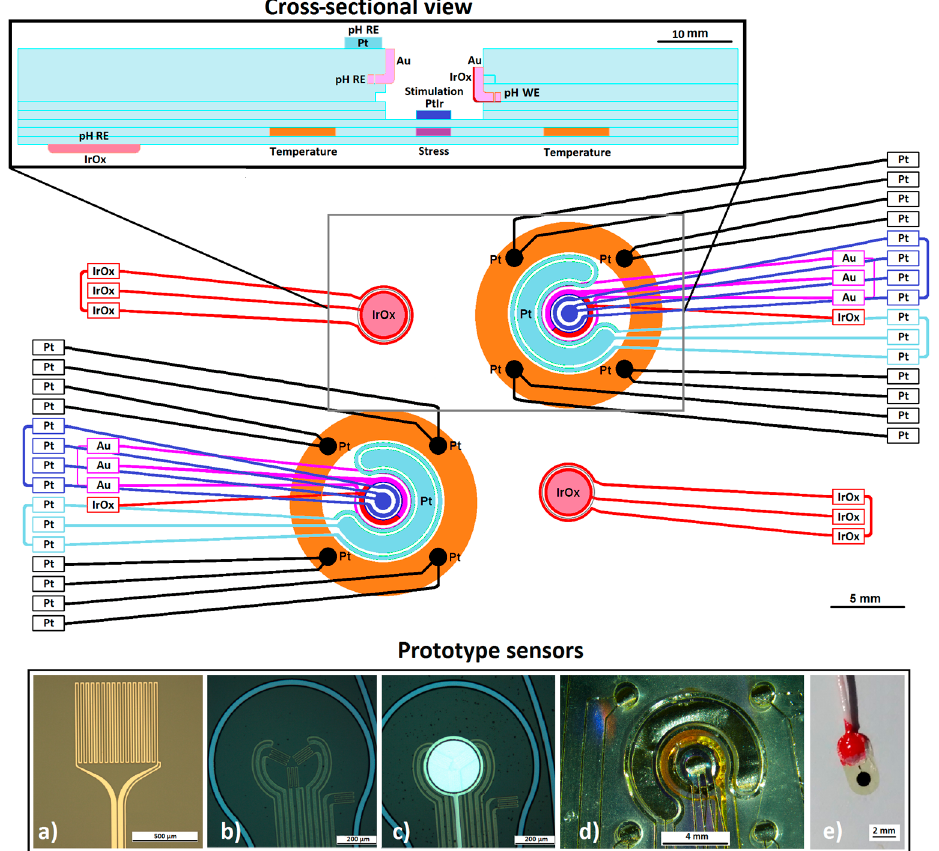
Figure 2. Conceptual sketch of the dual multi-sensor array configuration. A cross-sectional view of the array is shown ( top ). It depicts a PtIr stimulation electrode ( blue ) positioned above a stress strain gauge ( purple ) as well as surrounded by an IrOx sputtered on gold pH working electrode (WE) ( red ), an Au ( pink ) and Pt ( turquoise ) reference pH electrode (RE) and four Pt impedance electrodes ( black ). The temperature strain gauge ( orange ) is positioned around the electrodes and is prototyped with the strain gauge shown in ( a ) [17,19]. The PtIr stimulation electrode is positioned directly above the stress strain gauge depicted in prototype ( b , c ) [20]. Prototype ( d ) shows a picture of the prototype multi-sensor array with the four Pt impedance electrodes surrounding the pH and stimulation electrodes. The pH electrodes allow a differential measurement to be made between the working electrode (IrOx) and reference electrodes (Au electrode, semilunar shaped Pt electrode and more distant IrOx for pH measurement of the surrounding medium, intended to be insensitive to stimulation) while stimulating via the PtIr electrode is performed. The pH sensor used to verify the pH electronics is shown in ( e ).